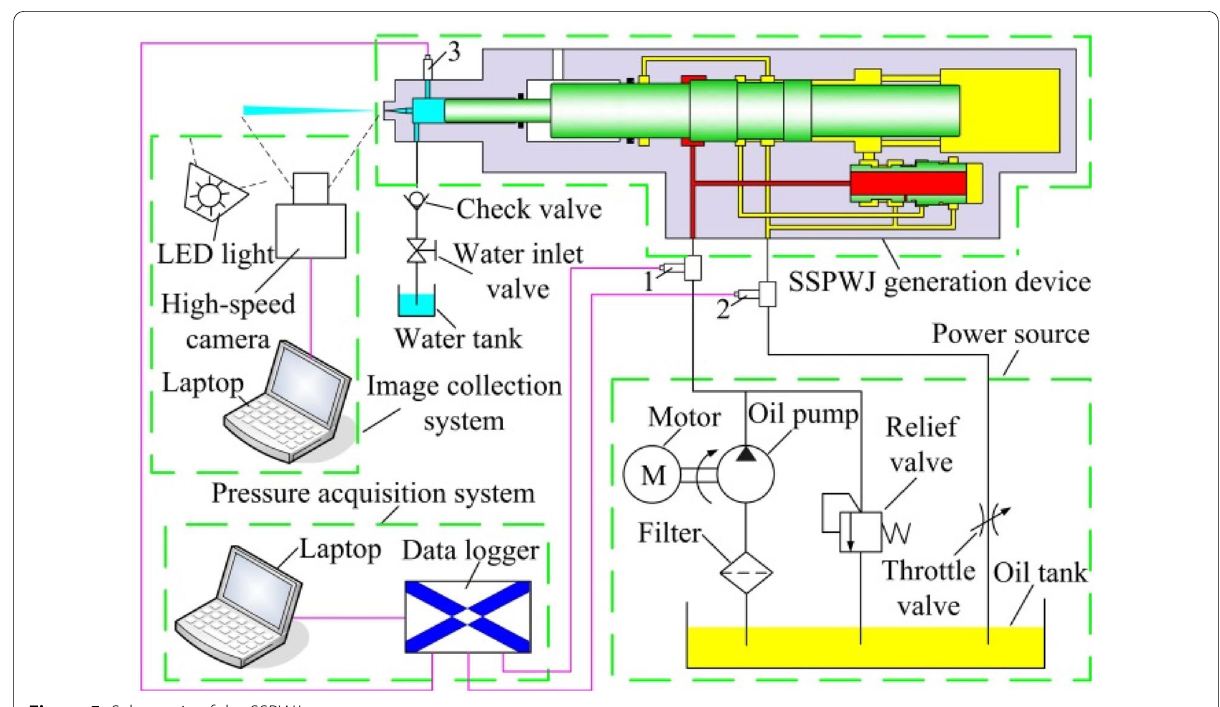
Figure 5 Schematic of the SSPWJ pressure test